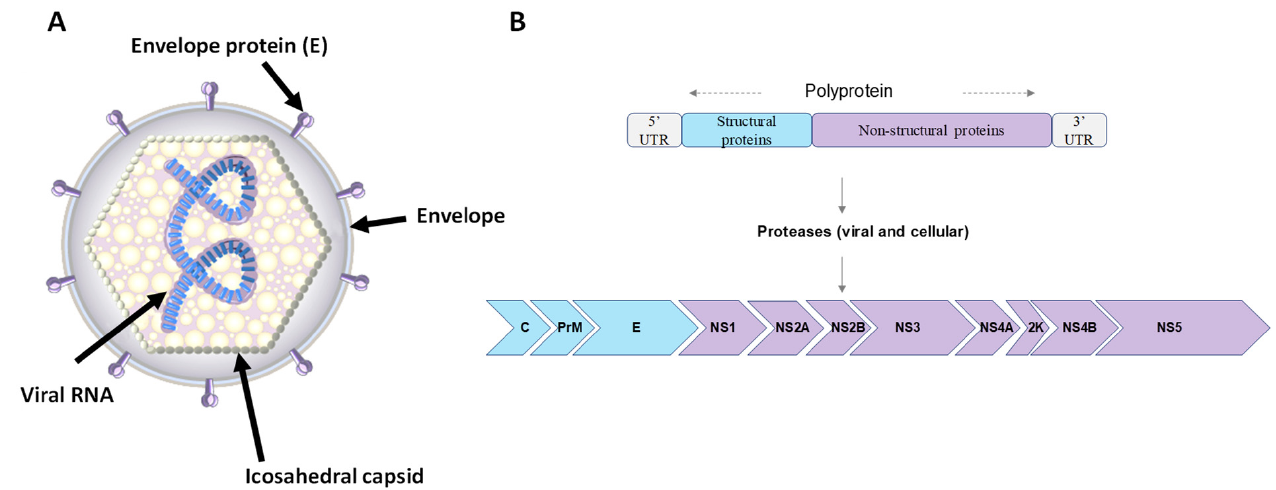
Figure 1. Usutu virus virion structure and genomic organization. ( A ) Schematic representation of USUV virion structure: virion surface is enhanced with the envelope and membrane proteins, anchored in a lipid bilayer with an icosahedral symmetry. ( B ) Representation of the USUV genome. RNA of positive polarity composed of 11 genes. A single reading frame codes for a polyprotein which is cleaved co- and post-translationally by viral and cellular proteases releasing 3 structural proteins (C, prM, and E) and 8 non-structural proteins (NS1, NS2a, NS2b, NS3, NS4a, 2K, NS4b, and NS5).